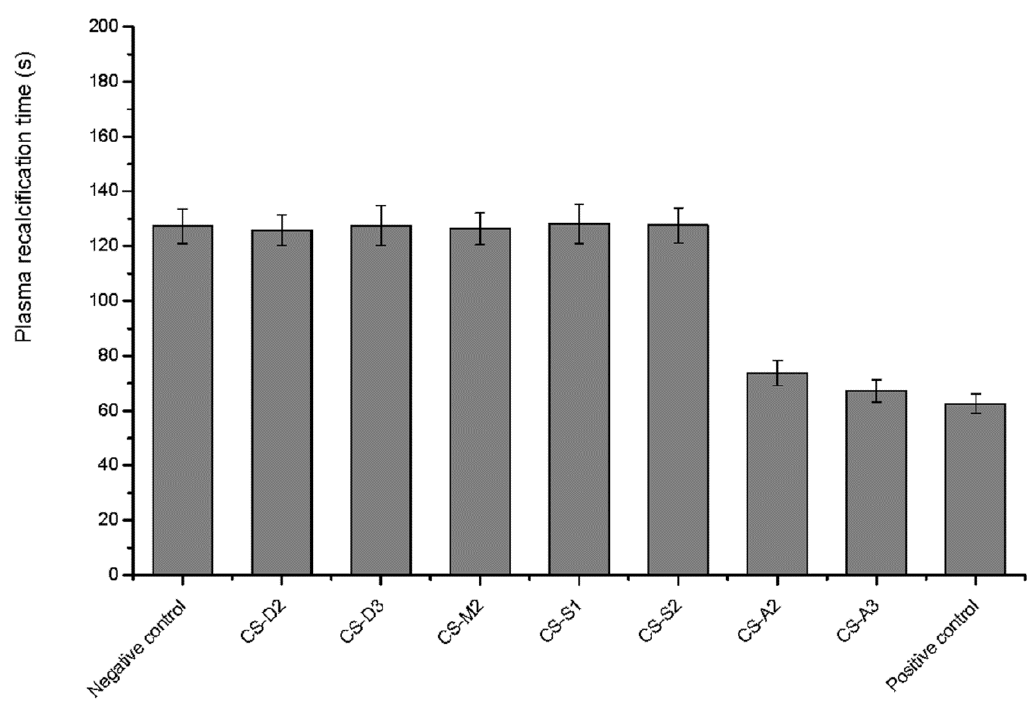
Figure 9. The plasma recalcification time of chitosan with various molecular parameters.